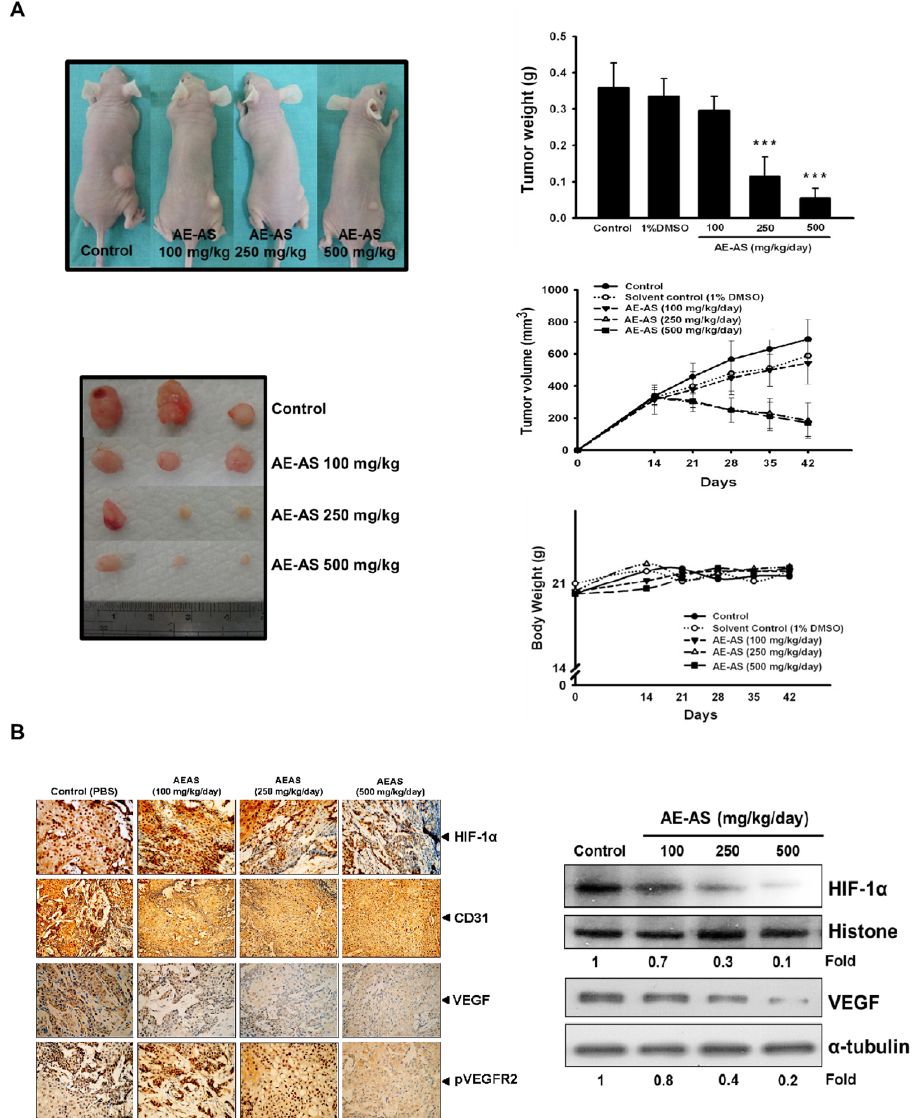
Figure 6. AE-AS reduced tumor angiogenesis and growth. The mice were injected with T24 cells (s.c.) for 15 days followed by treatment with different doses of AE-AS for 30 days, the images of tumor sections, tumor size and weight, and body weight of mice were measured ( A ). The protein expression of HIF-1 α , VEGF, CD31 and pVEGFR2 in tumor tissues was determined by immunohistochemical staining or Western blotting assay ( B ). Data was expressed as mean ± SEM (n = 5). *** P < 0.001 versus untreated cancer mice (Control